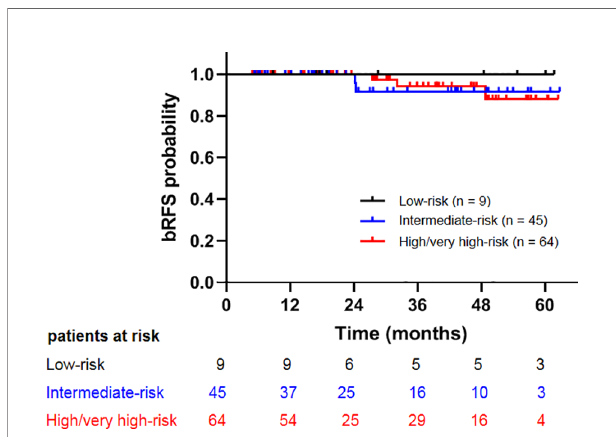
FIGURE 2 | Comparison of biochemical relapse free survival among patients with low-, intermediate-, and high-/very high-risk prostate